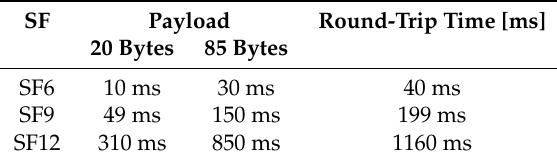
Table 6. ToA per message size (request and response) and round-trip time of our experimental